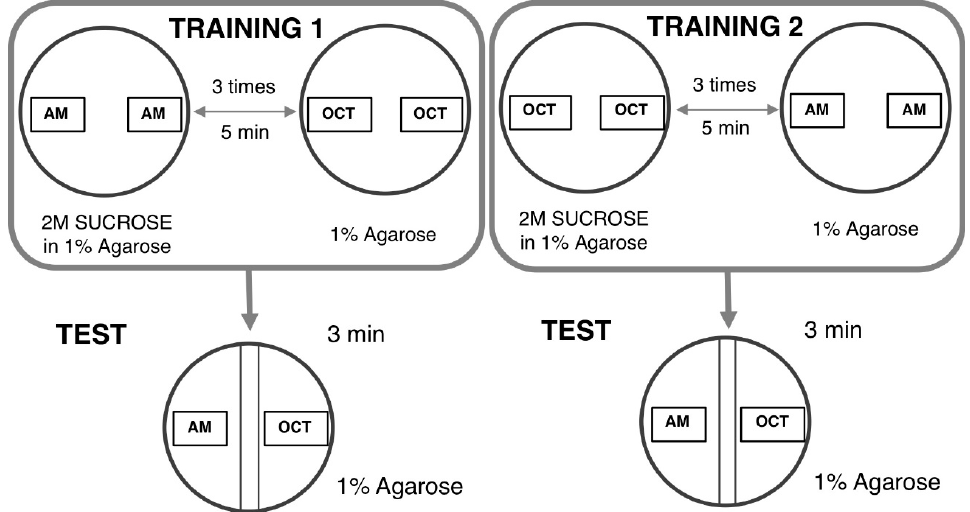
Figure 3. Principle of the odor-taste learning test. TRAINING 1: In one of the groups, n-amyl acetate (AM) is added with a sucrose reward and 1-octanol (OCT) is subsequently added without a reward. TRAINING 2: The other group receives reciprocal training. TEST: After each training exposure, larvae are tested for their choice between AM and OCT.